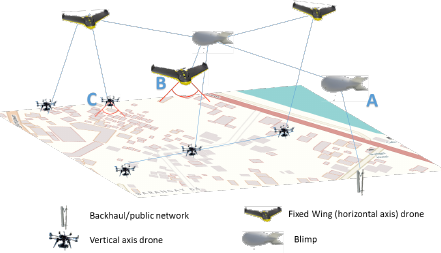
Figure 5. Multi-layer organization of the drones' fleet, highlighting the instantaneous communication links.